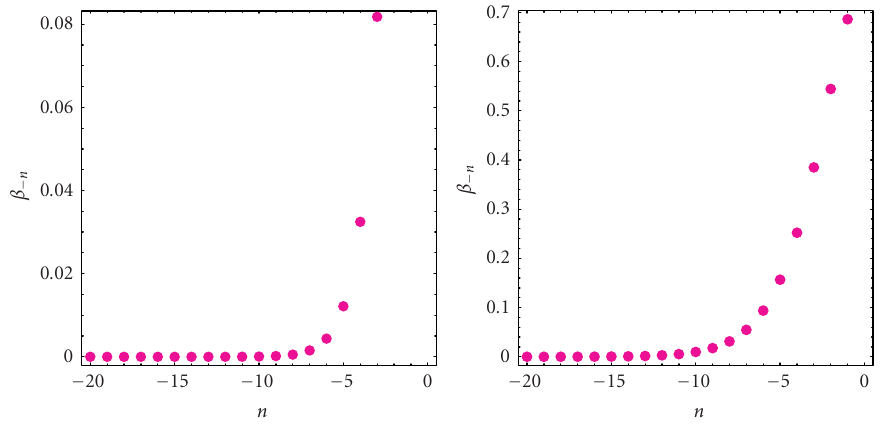
Figure 3.8. The curve of β − n ( n | q ) and lim n →∞ β − n = nζ q ( n +1) = 0, q = 3 / 10, 5 / 10 .